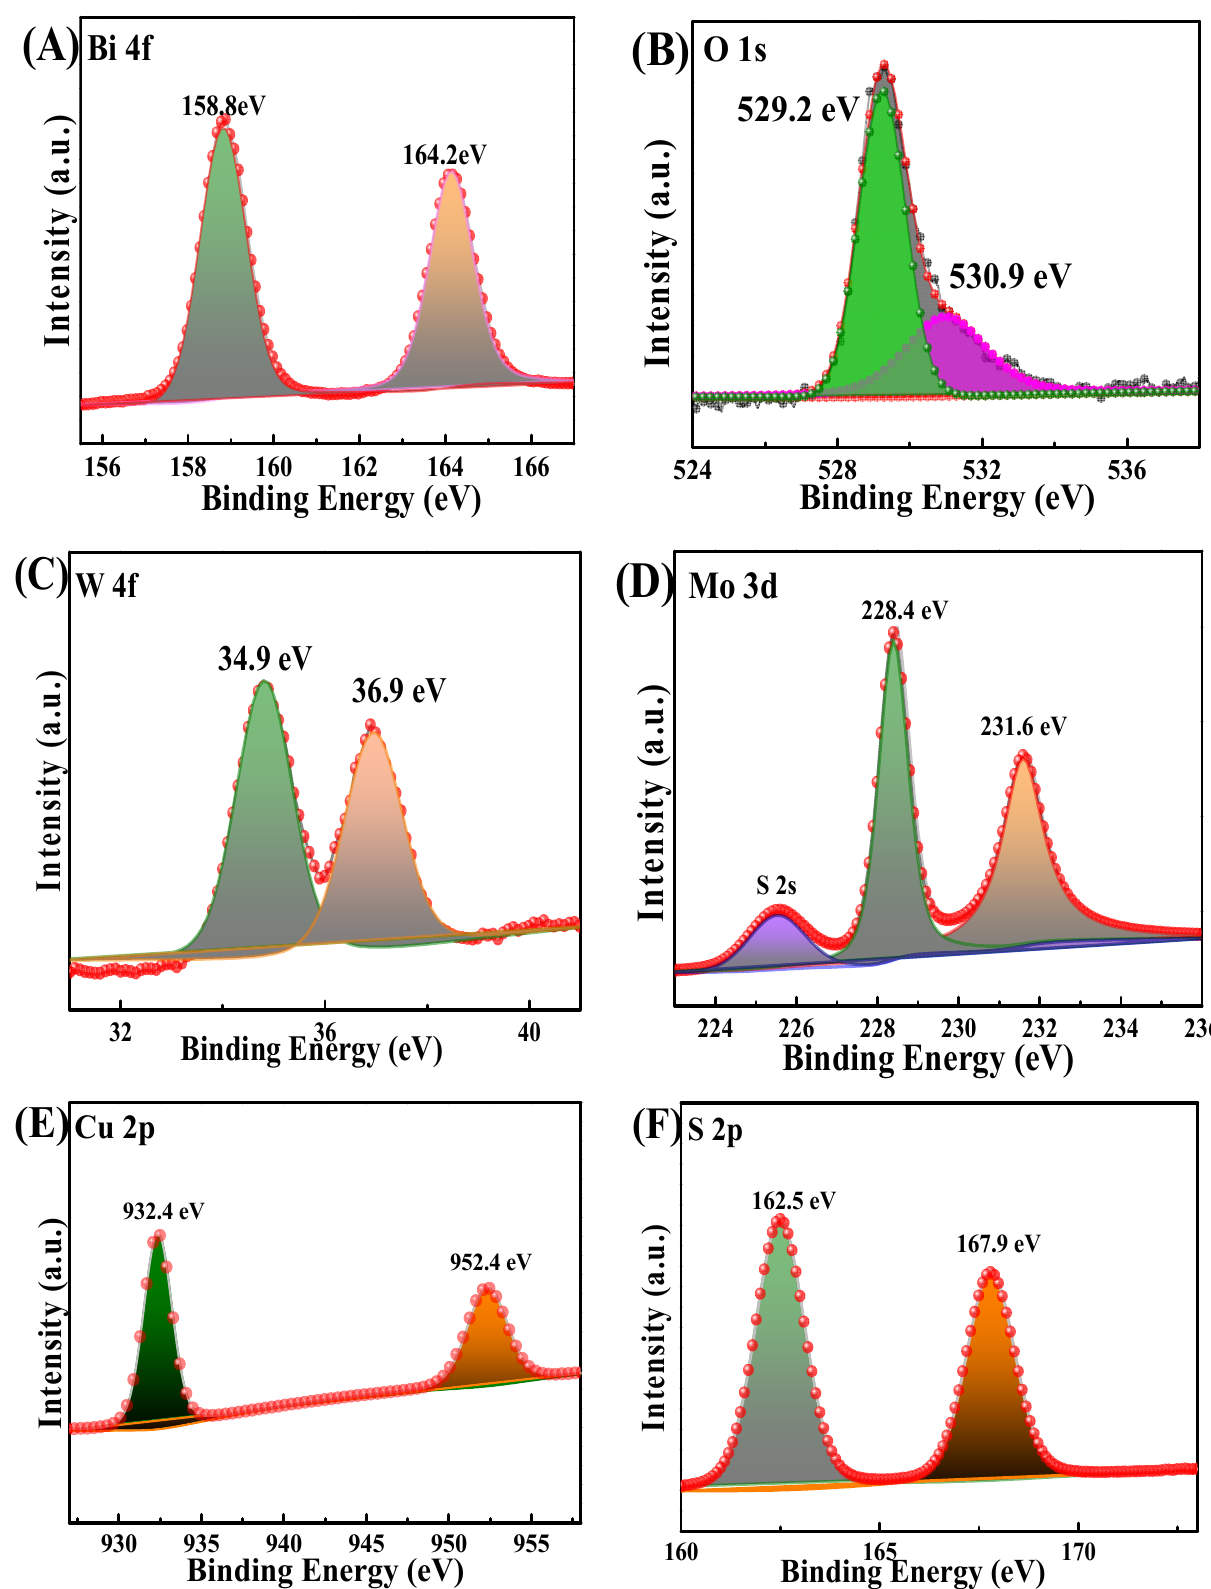
Figure 2. XPS spectra of Bi 4f ( A ), O 1s ( B ), W 4f ( C ), Mo 3d ( D ), Cu 2p ( E ), and S 2p ( F ) of CuS/MoS 2 /Bi 2 WO 6 -5%.